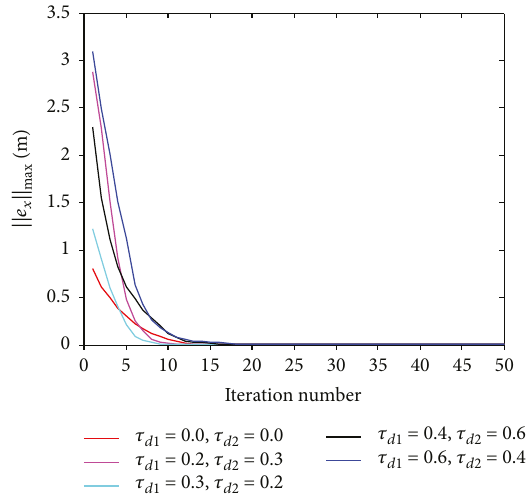
Figure 8: Maximum tracking errors of position with di ff erent time delays.